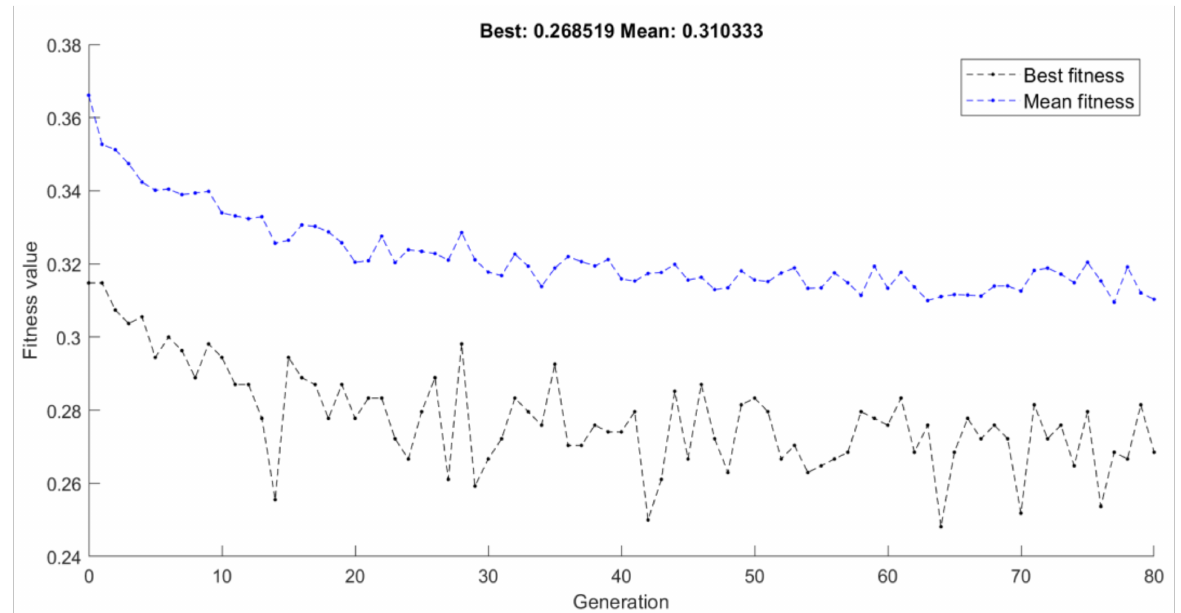
Figure 5. Fitness with respect to number of generations for GenWrapper. The black and blue dashed lines show the best and the mean fitness achieved at each generation,